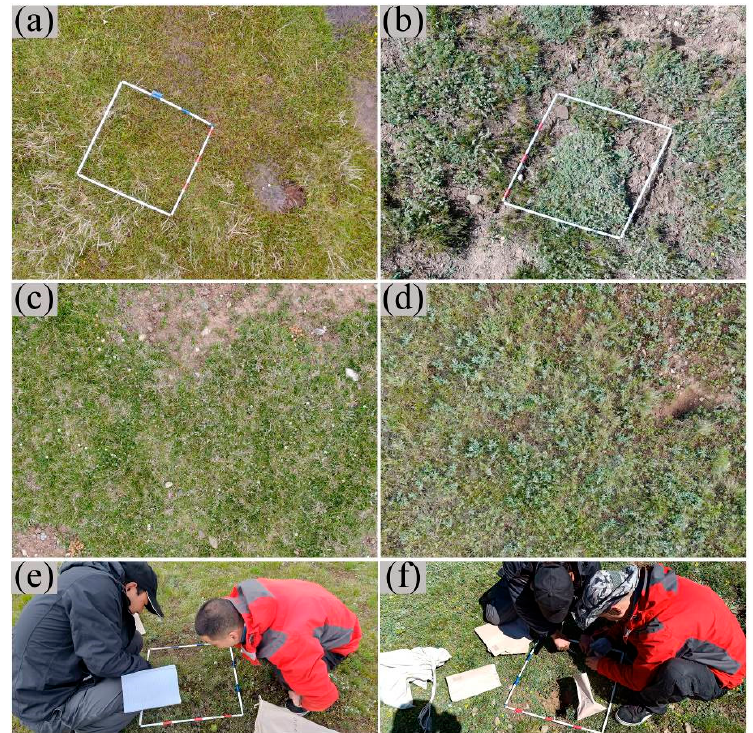
Figure 12. ( a ) and ( b ) synchronous survey vegetation species composition by the UAV and Quadrat, ( c ) and ( d ) monitoring of vegetation species composition by the UAV , ( e ) ground validation of vegetation species composition and ( f ) vegetation biomass investigation of four functional